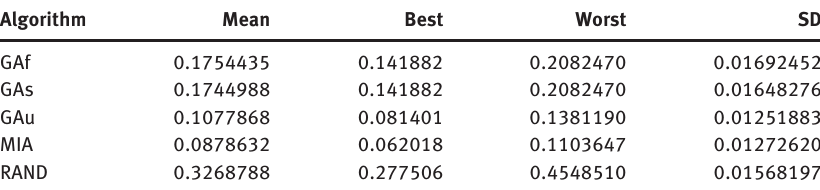
Table 7. Length 51 32 PSK